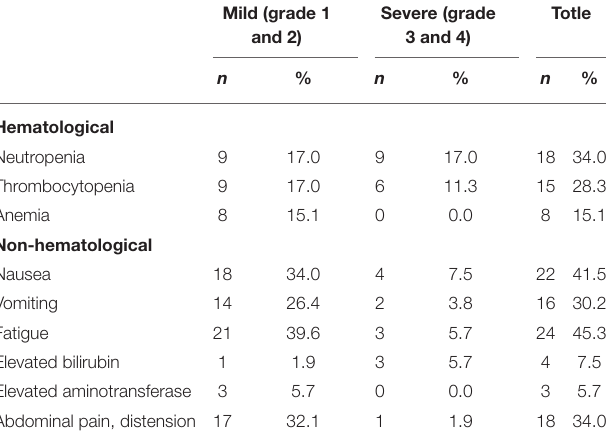
TABLE 6 | Toxicity of cCRT ( n =